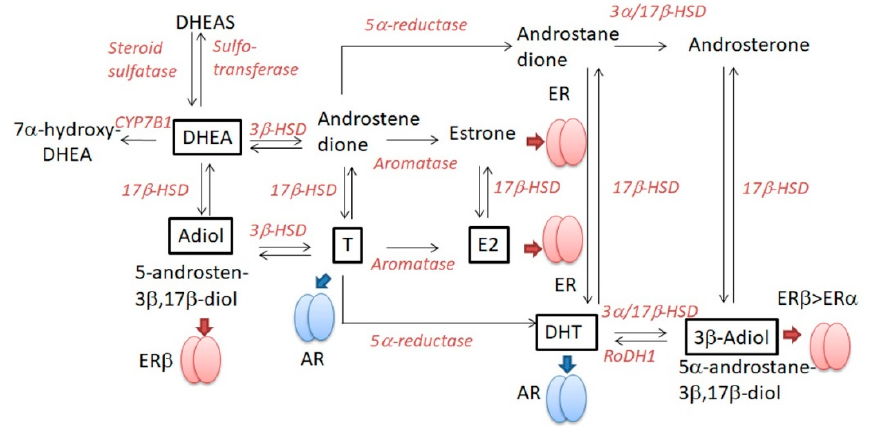
Figure 3. Dehydroepiandrosterone (DHEA) metabolizing pathway. DHEAS, dehydroepiandrosterone sulfate; DHT, dihydrotestosterone; T, testosterone; E2, estradiol; AR, androgen receptor; ER, estrogen receptor; 17 β -HSD, 17 β -hydroxysteroid dehydrogenase; RoDH1, retinol dehydrogenase type 1; (cid:31), binding to the steroid receptor described.